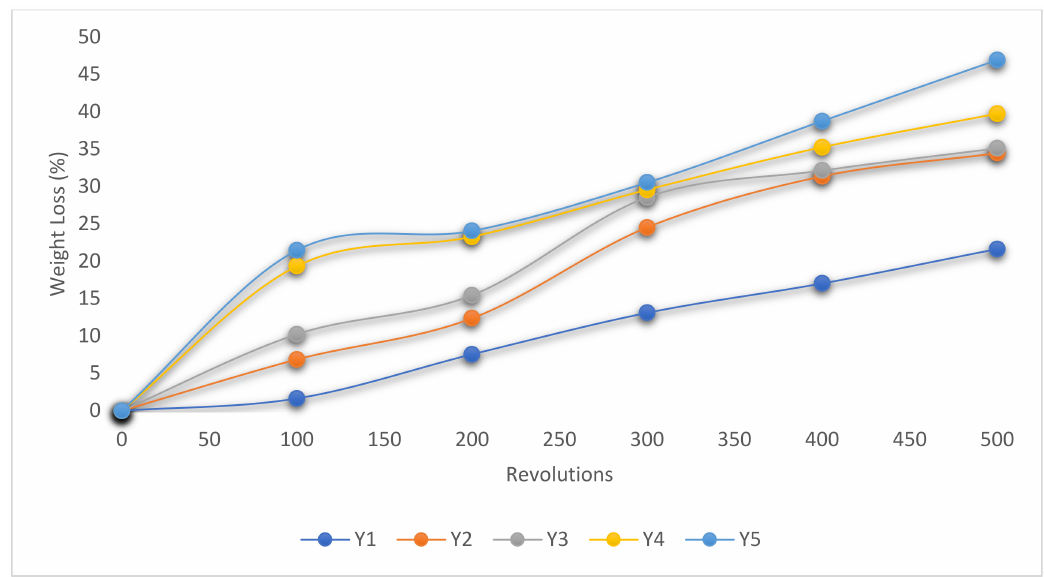
Figure 7. Abrasion resistance test